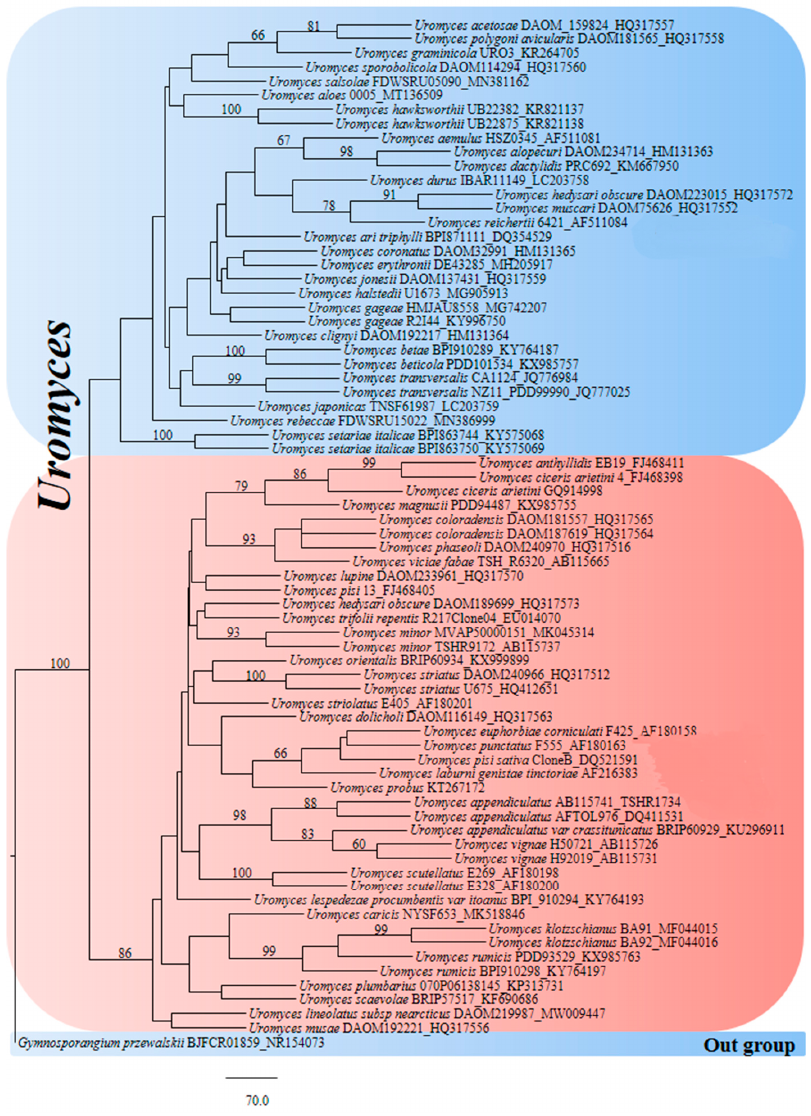
Figure 3. Phylogram generated from PAUP analysis of Uromyces species of ITS sequences. The scale bar indicates 70 changes and outgroup Gymnosporangium przewalskii BJFCR01859_NR154073. Bootstrap values of MP > 60% are given above branches, and 72 sequences are included in the phylogenetic analyses. The best maximum parsimony (MP) dataset consists of 394 total characters, of which 164 were constant, 156 parsimony-informative, and 74 parsimony-non-informative. The parsimony analysis of the data matrix showed a thousand equally parsimonious trees with a length of 917 steps in the first tree (CI = 0.408, RI = 0.702, RC = 0.286, HI = 0.592).